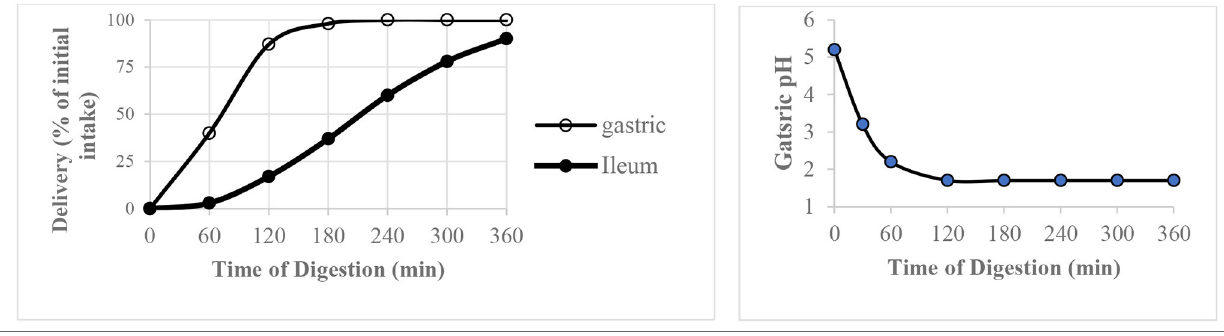
Parameters of in vitro